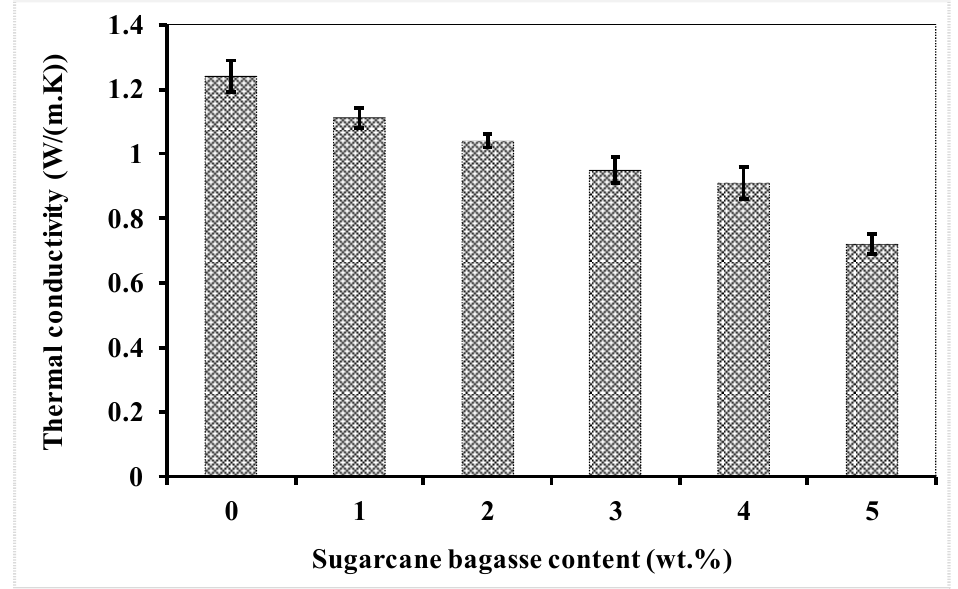
Figure 10. Thermal conductivity of adobes reinforced with sugarcane bagasse.